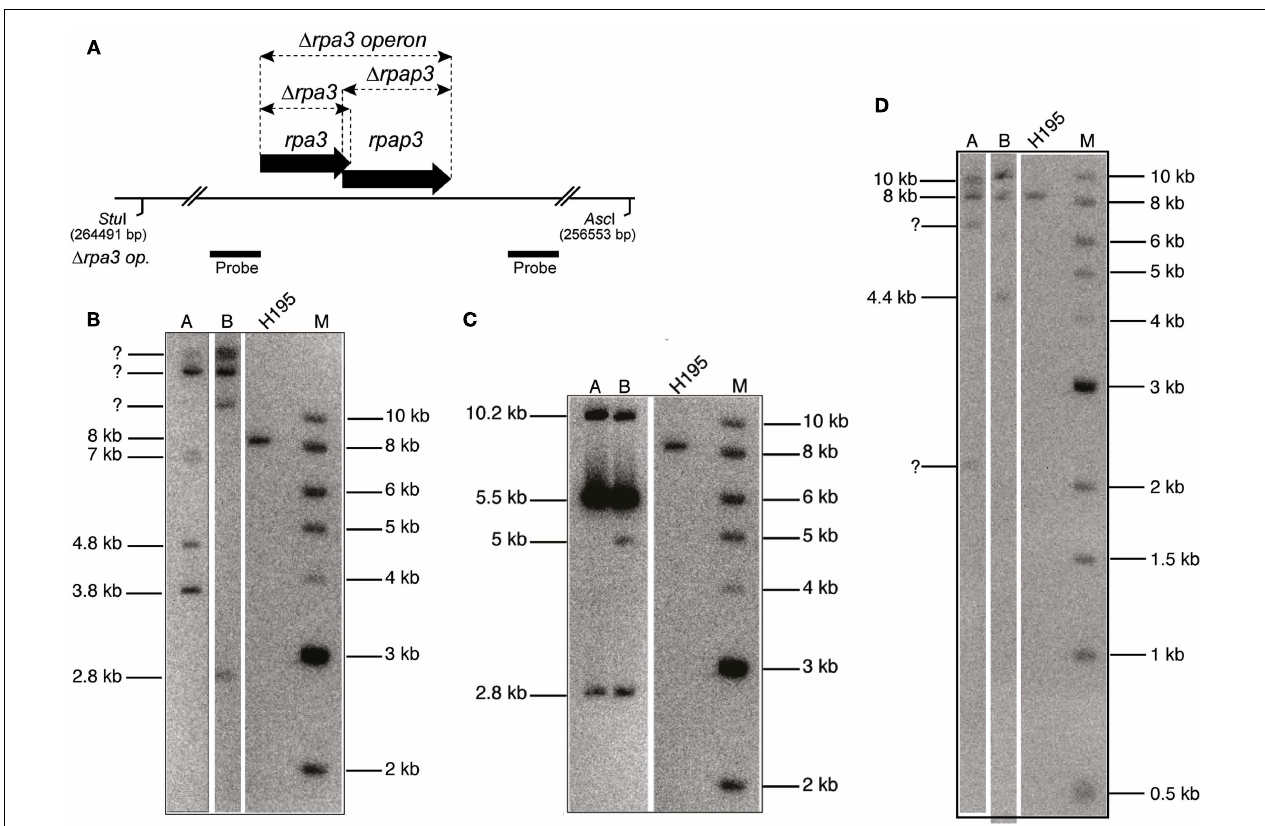
with Asc I and Stu I, and probed with flanking regions of rpa3 op. , as shown in (A) , indicates failure to generate ∆ rpap1 ∆ rpa3 mutant as bands of the expected size for deletion are not seen (2.8 and 5kb). (D) Southern blot of genomic DNA cut with Asc I and Stu I, and probed with flanking regions of rpa3 op ., as shown in (A) indicates failure to generate ∆ rpa1 operon ∆ rpa3 operon mutant as bands of the expected size for deletion are not seen (2.8 and